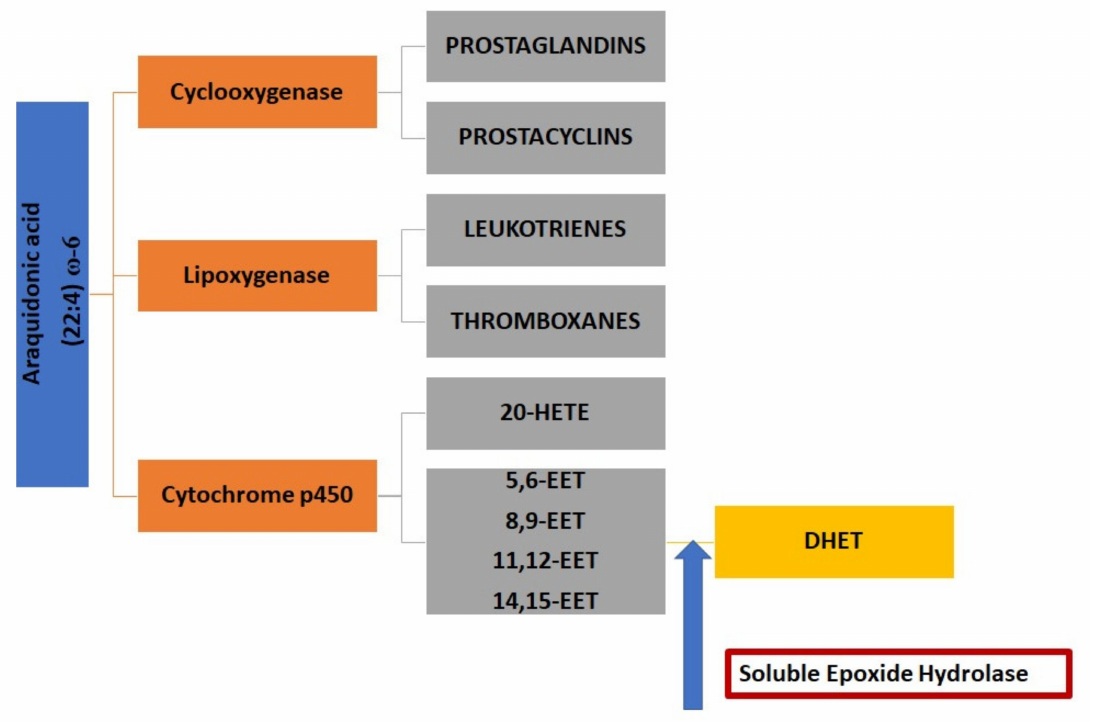
Figure 1. Arachidonic acid (ARA) metabolism tree. Epoxyeicosatrienoics acid (EET) generation and action site of